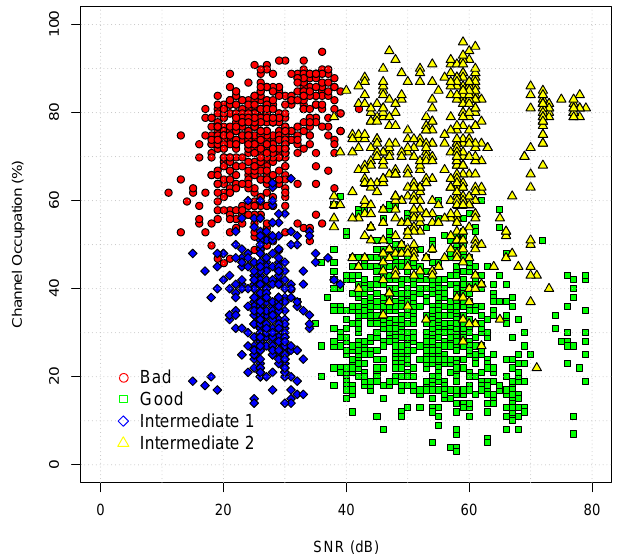
Figure 4. Identification states based on the HMM4.